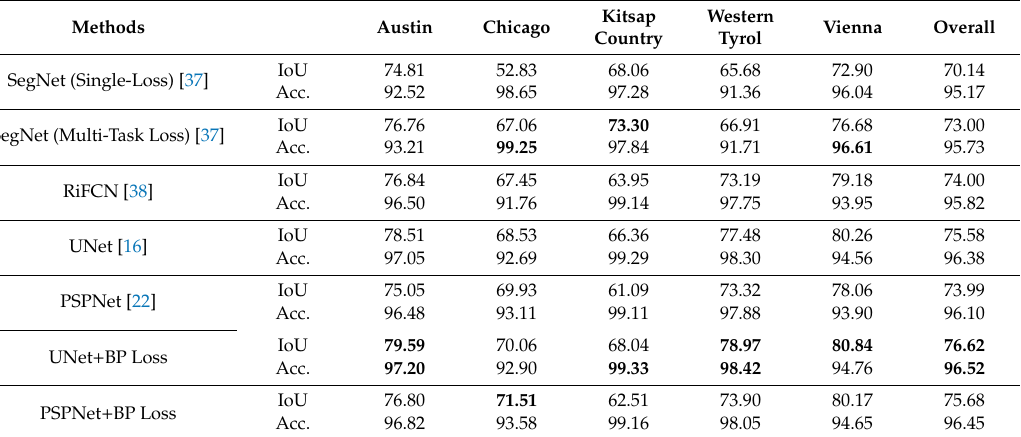
Table 6. SOTA comparisons on the INRIA